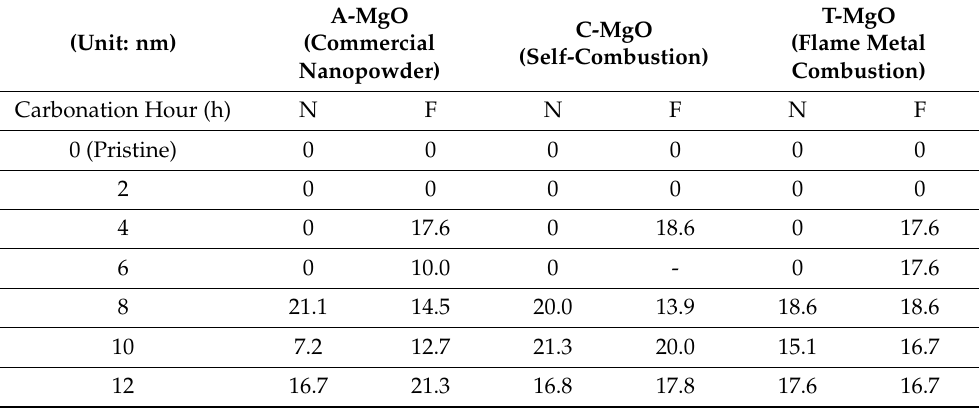
Figure 2. Morphological changes in the 3 MgO nano-adsorbents between pristine and 4 h carbonation products through the forced (F) or non-forced (N) wet carbonations for ( a ) A-MgO, ( b ) C-MgO and ( c ) T-MgO analyzed by FE-SEM (scale bars: 100 nm for pristine particles and 10 µ m for carbonated samples) (SEM images at full carbonation time conditions are in the Supplementary Materials) SI). Table 2. Crystallite sizes of nesquehonite of three MgO nano-adsorbents at different carbonation times (unit: